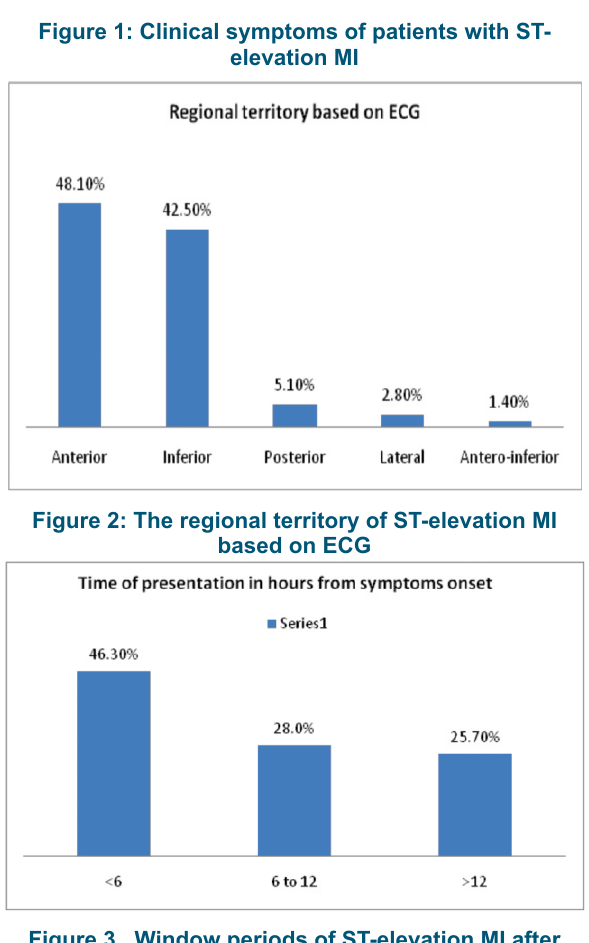
Figure 3. Window periods of ST-elevation MI after symptoms